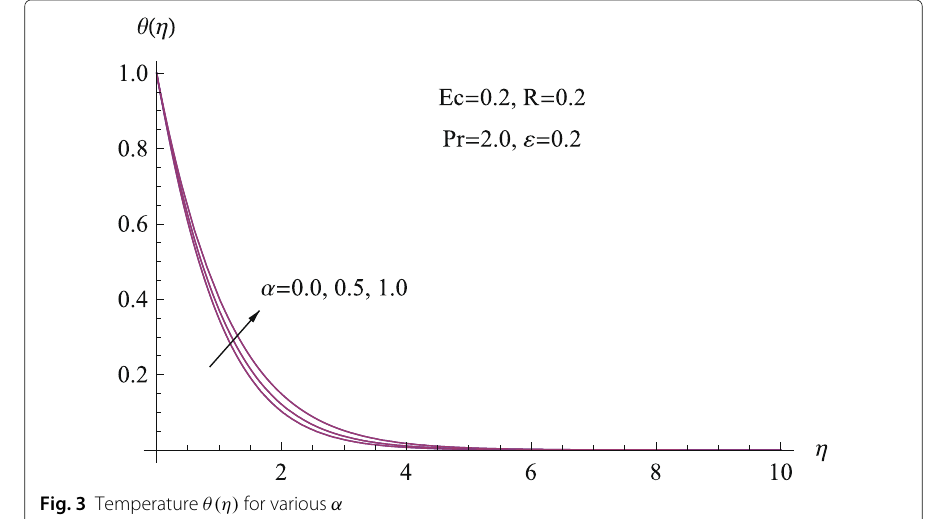
Fig. 3 Temperature θ(η) for various α